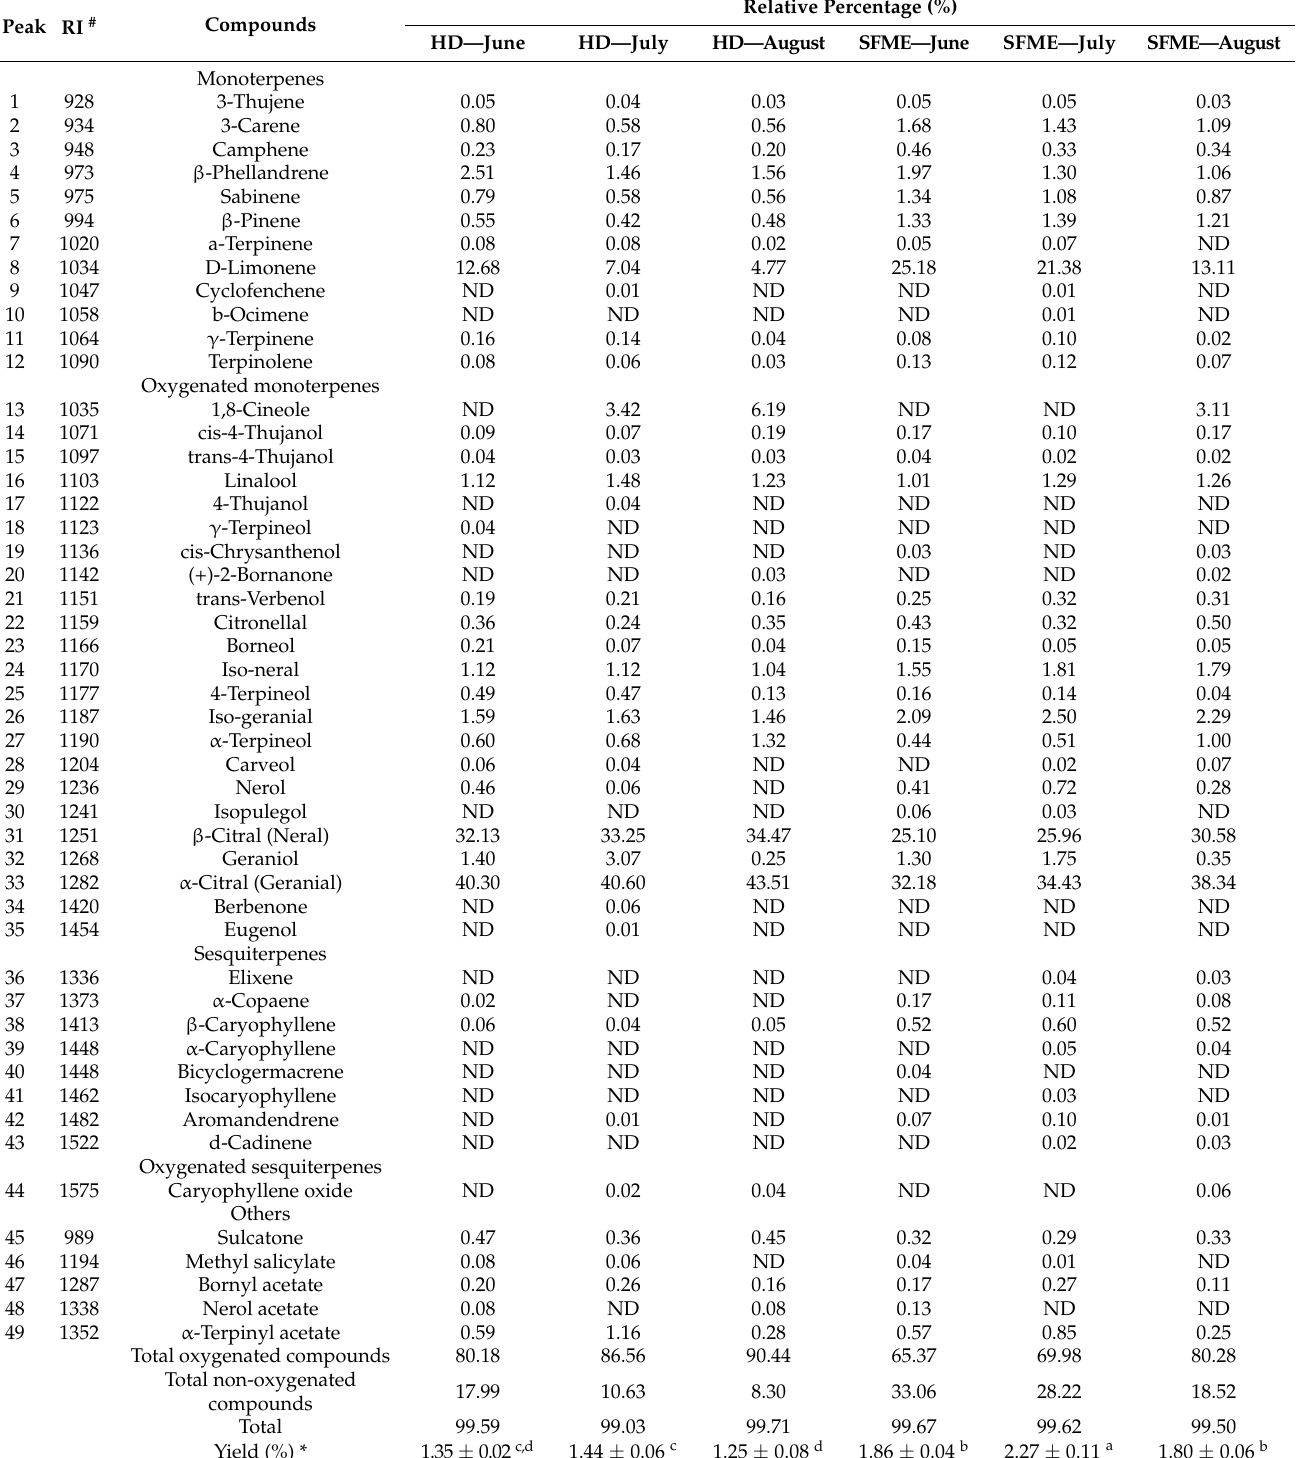
Table 3. Chemical composition of L. cubeba fruit essential oils from hydrodistillation (HD) and solvent-free microwave extraction (SFME) at different harvesting